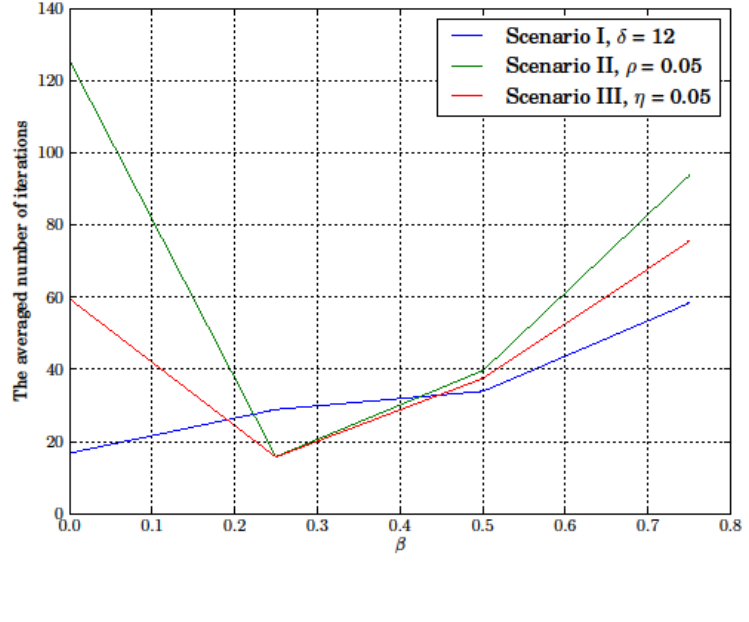
Figure 8. The averaged number of iterations required before the termination criteria were satisfied for different scenarios in Example